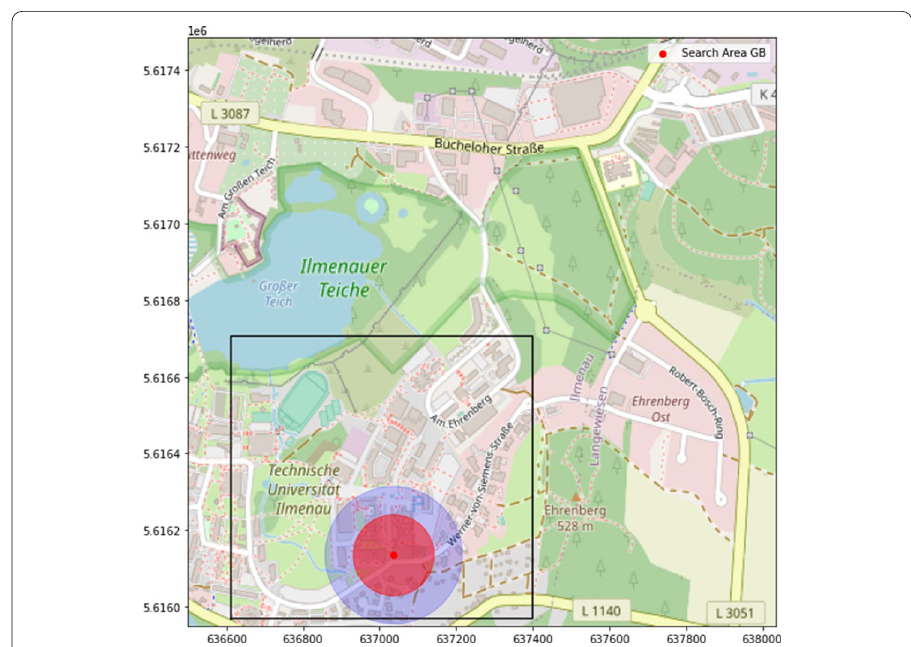
Fig. 14 An example of a 75 m radius search area from the proposed method and a 127 m radius search area when using just simulation data to predict real